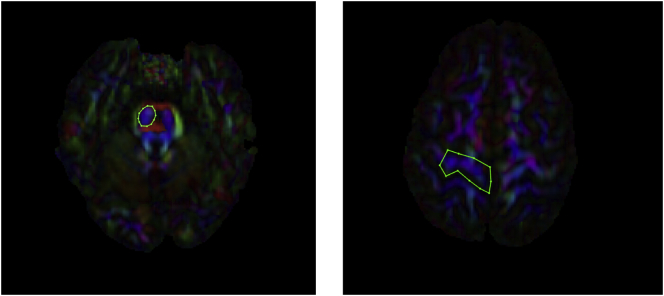
A visual representation of ROI masks for the CST. NOTE: ROI: Region of interest; CST- corticospinal tract.